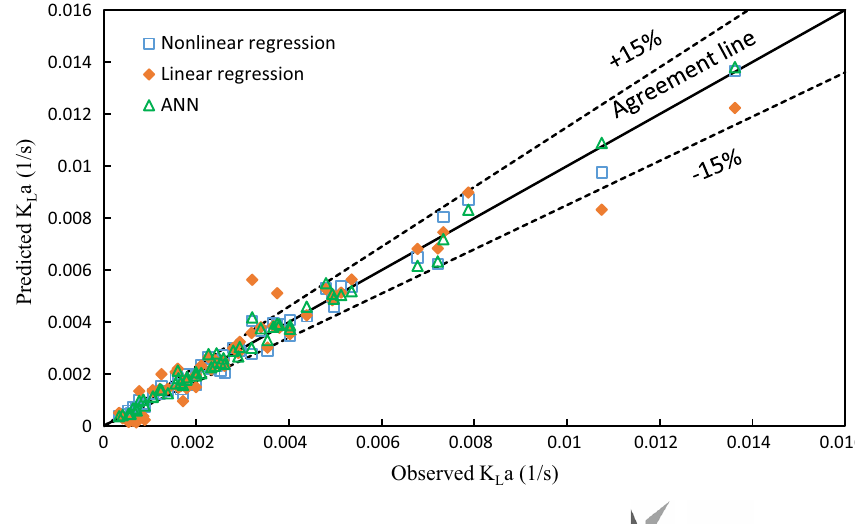
Fig. 9 Experimental versus pre- dicted values of K L a by nonlin- ear regression, linear regression and ANN with training